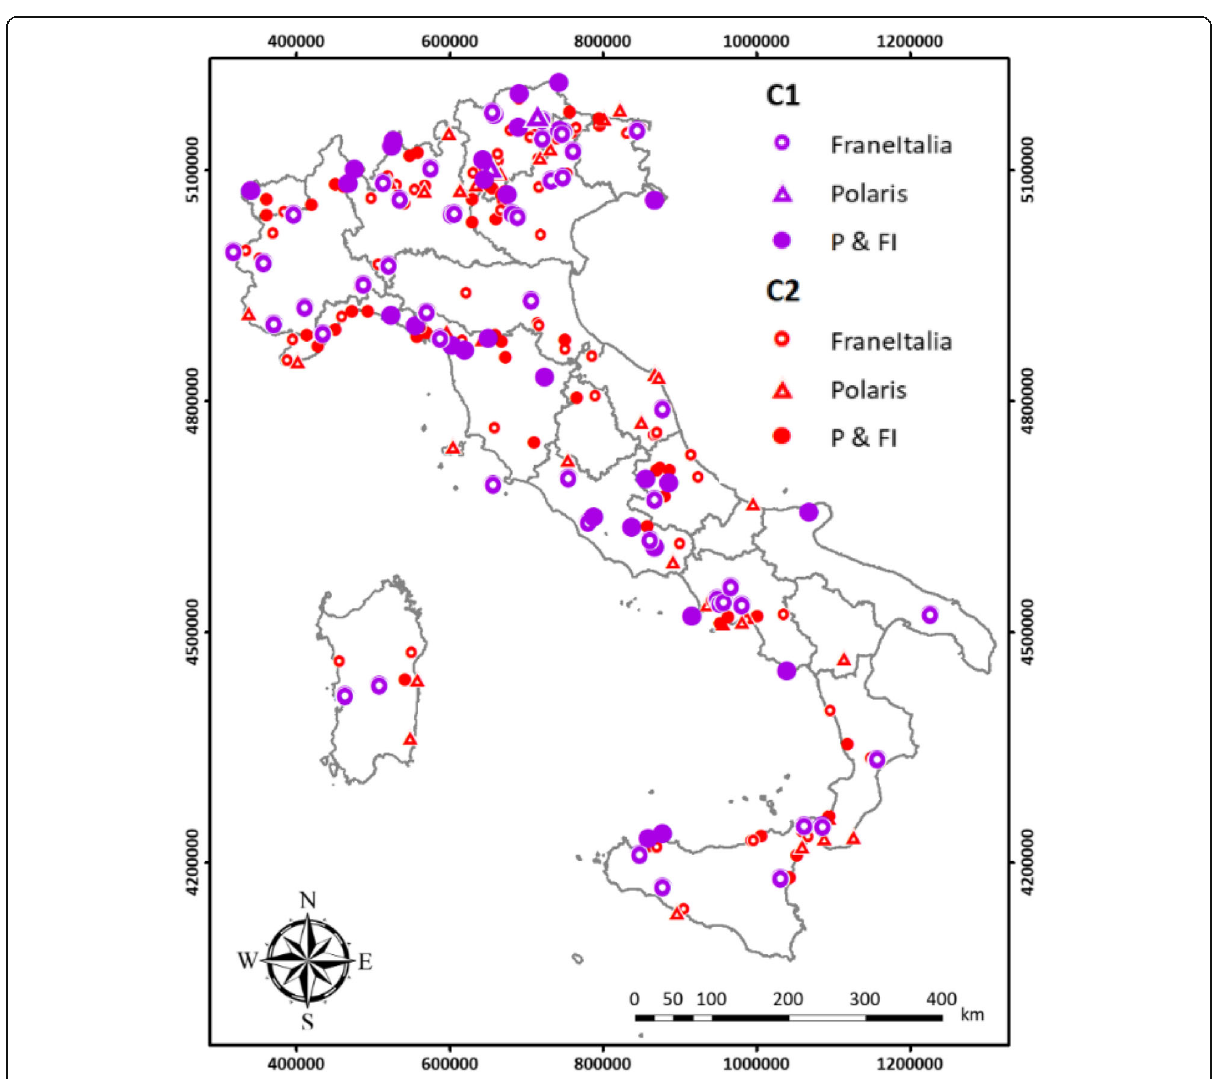
Fig. 9 Landslide records with victims and/or missing persons (C1) and injured persons and/or evacuations (C2) recorded in the FraneItalia catalog, Polaris catalog or both catalogs (P &